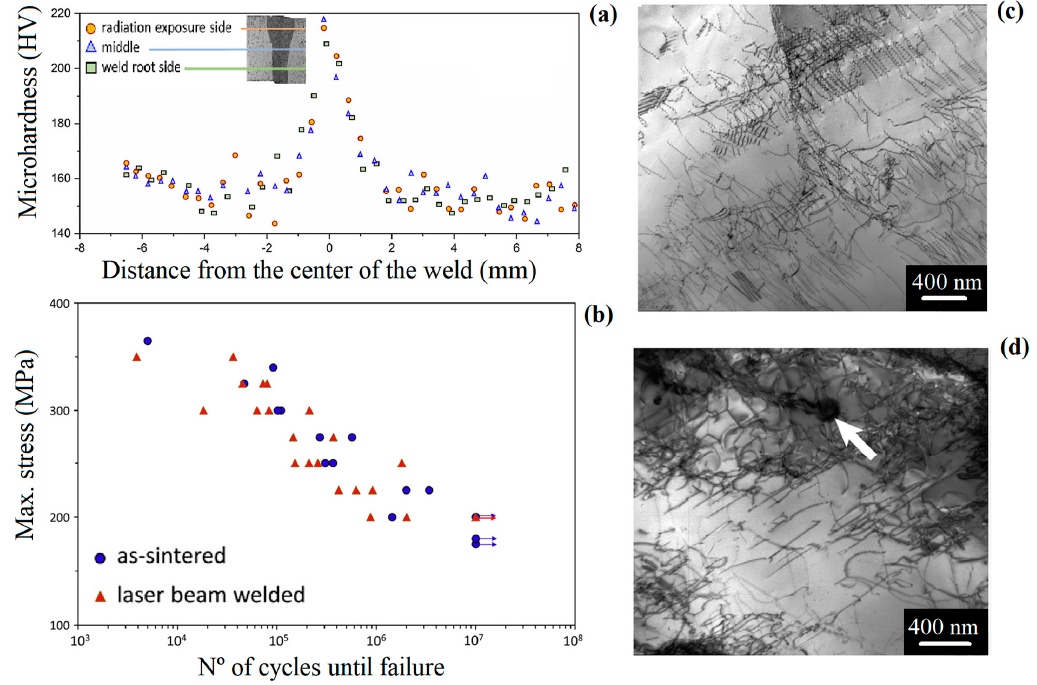
Figure 8. ( a ) Hardness distribution along different regions of CoCrFeMnNi HEA, ( b ) fatigue behavior of the this alloy as-sintered and LBW, TEM microstructure of the alloy ( c ) as-sintered, and ( d ) laser beam welding (LBW) after 10 7 cycles. Adapted from [35].